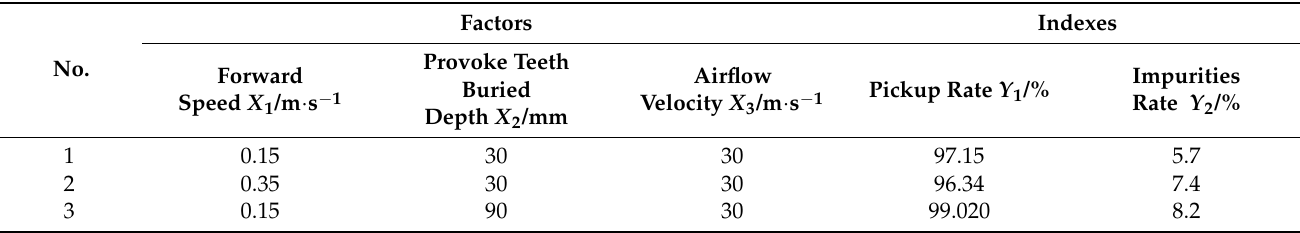
Table 3. Experimental schemes and results with the Box–Behnken